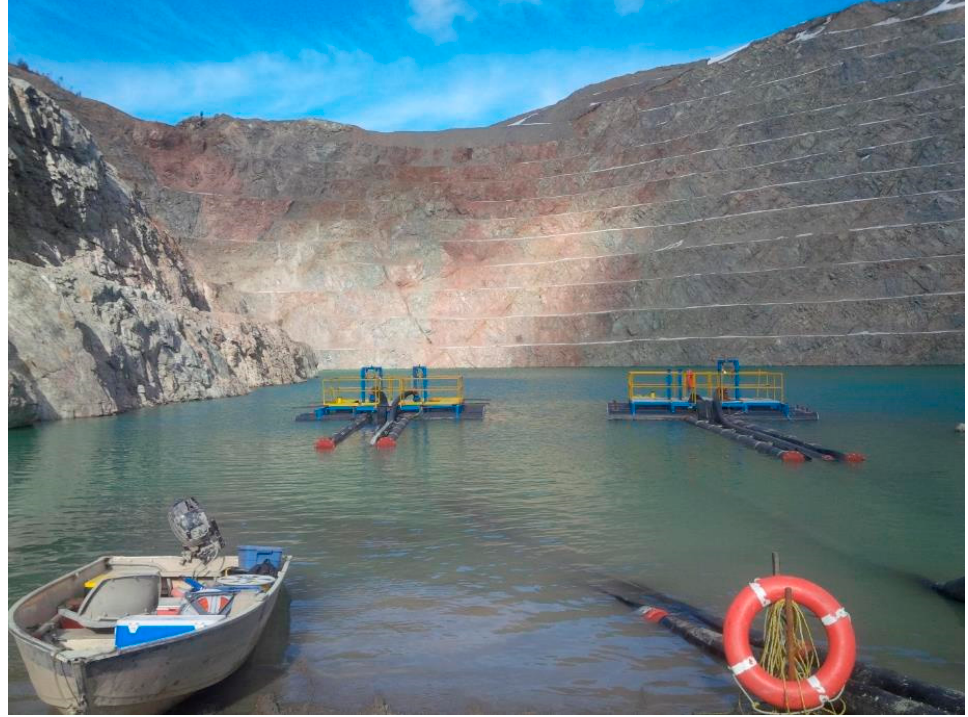
Figure 8. Springer Pit Lake and dewatering infrastructure at Mount Polley Mine, BC, Canada.